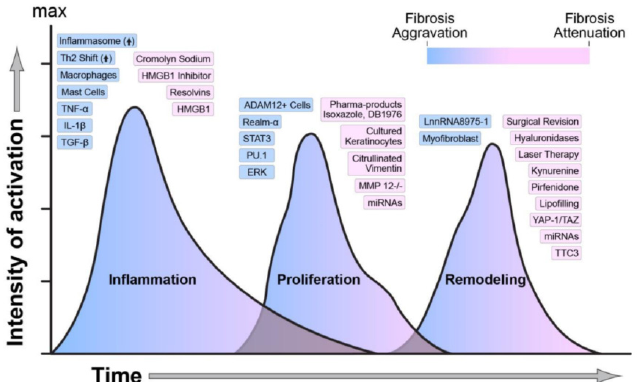
Figure 4. Regulators of wound healing and scarring (blue indicates activation, and pink indicates attenuation of fibrosis) [3].